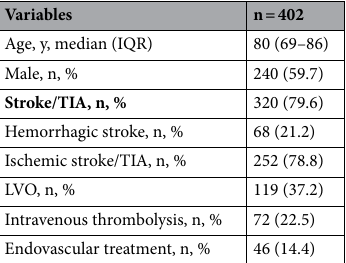
Table 1. Demographic features of all patients. IQR, interquartile range; LVO, large vessel